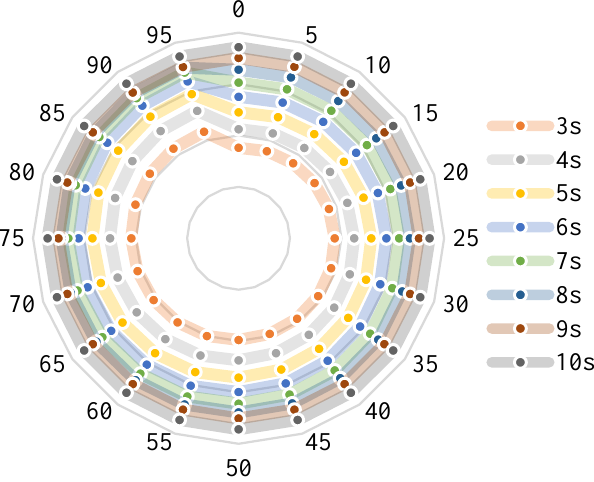
Figure 11. Flow fluctuation graph when p takes different values. As shown in Figure 12: when p takes different values, the flow chart of the autonomous vehicle matching the speed of the human-driven vehicle. Table 5 shows some flow data of automatic driving to match human driving with different p in the actual analysis.